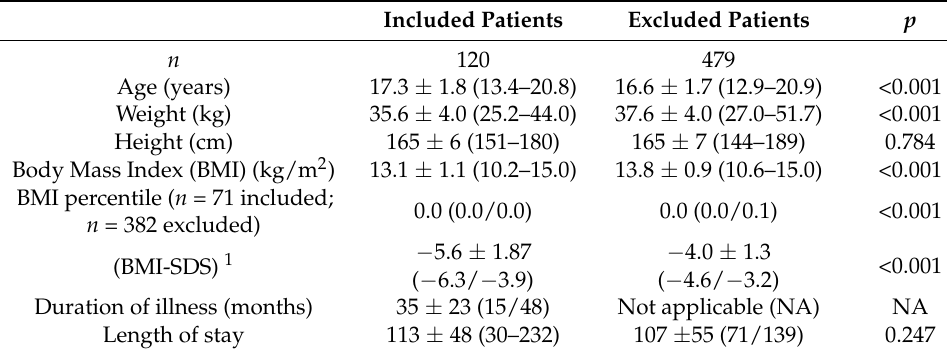
Table 2. Sample characteristics of included and excluded patients.